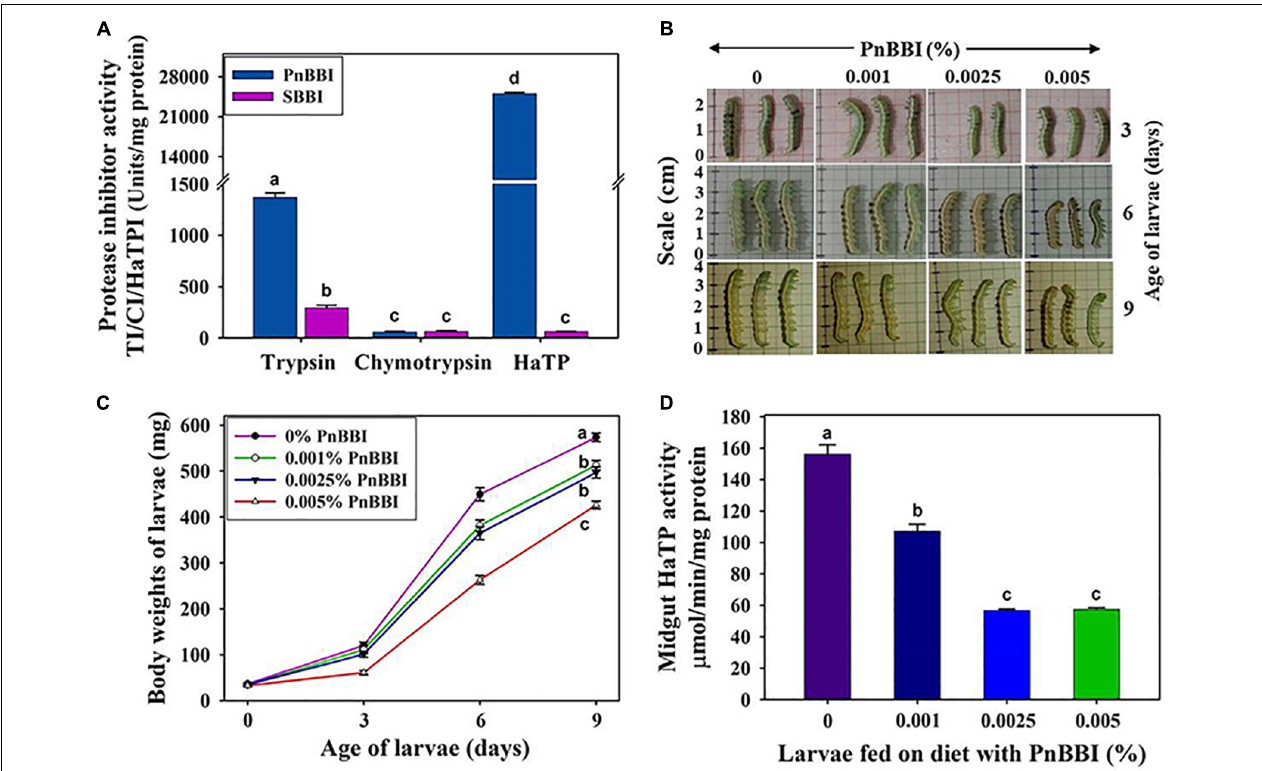
FIGURE 7 | In vitro and in vivo inhibitory effect of PnBBI on larvae of H. armigera . (A) Comparative inhibitory profiles of PnBBI and SBBI toward bovine trypsin, chymotrypsin and HaTP; (B) Photographs depicting the reduction in size of larvae fed on increasing doses (0.001, 0.0025, and 0.005%) of PnBBI containing diet as compared to larvae fed on control diet at the end of 3, 6 and 9 days of feeding. A set of thirty number of second instar larvae with approximate equal body size and weight were used in the present study for feeding with each concentration of PnBBI; (C) depletion in mean body weights of larvae after feeding on diet containing PnBBI as described above; (D) variation in the activity of midgut HaTPs in larvae after feeding on diet containing PnBBI as described above. The data represented is mean ± SE of three biological replicates. Different lower case letters “a, b, c, and d” indicate statistically different at a significant level ( P < 0.05) compared to control.